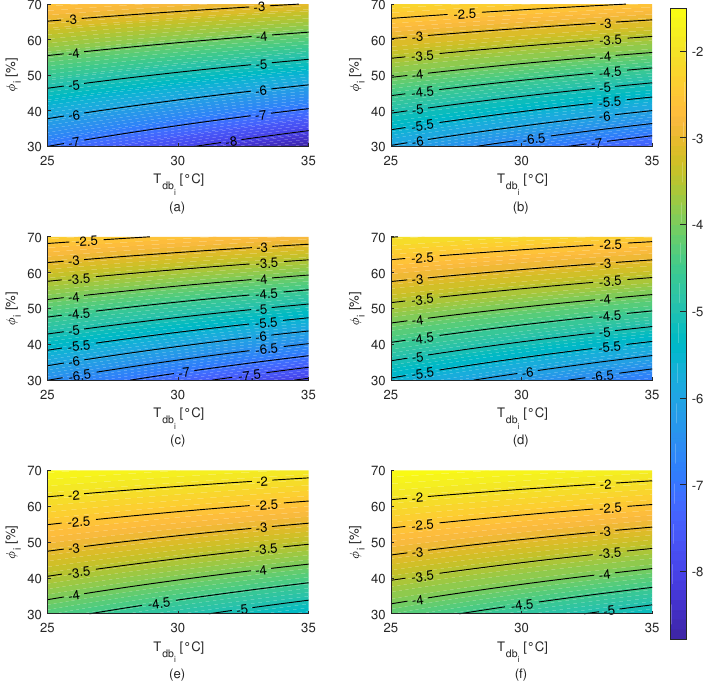
Figure A8. Difference between the outlet and inlet pad air dry-bulb temperature ( ∆ T ) as a function of dry-bulb temperature of inlet air ( T db ) and relative humidity ( φ i ) for the pad materials studied. ( a ) Cel- i lulose. ( b ) Small coconut shell (7.9–12.7 mm). ( c ) Big coconut shell (12.7–19.0 mm). ( d ) Burnt-clay bricks (12.7–19.0 mm). ( e ) Small pumice stones (34.9–45.0 mm). ( f ) Big pumice stones (45.0–55.5